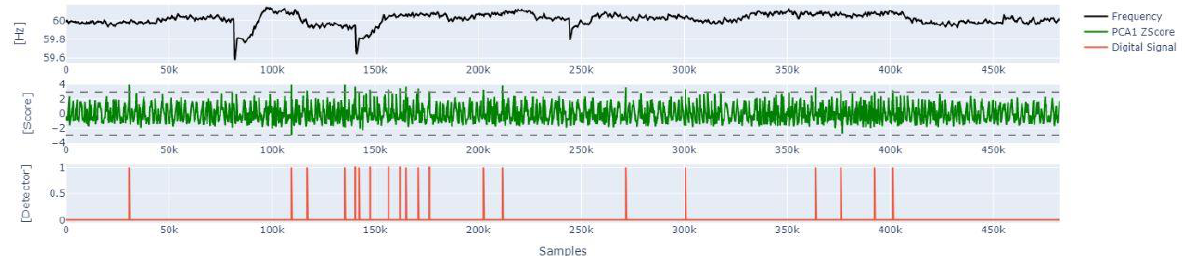
Figure 21. Event 2: detector event of PMU hydroelectric power station Salto Santiago.